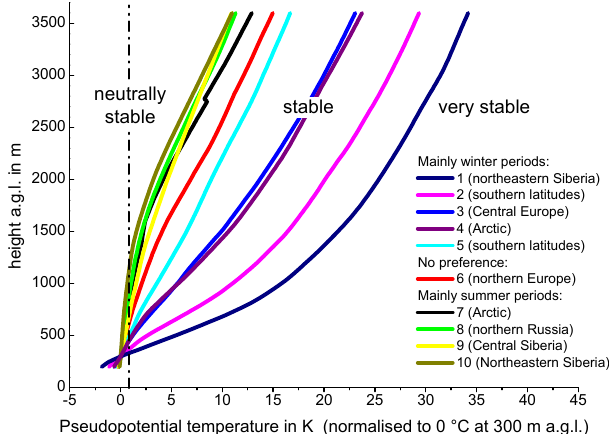
Fig. 9. Mean profiles of pseudo-potential temperature ( θ v ) for the ten trajectory clusters as a function of height. The profiles were part of the clustered variables in the k -means cluster analysis, and originated from the 19:00LT radiosounding at Bor. The